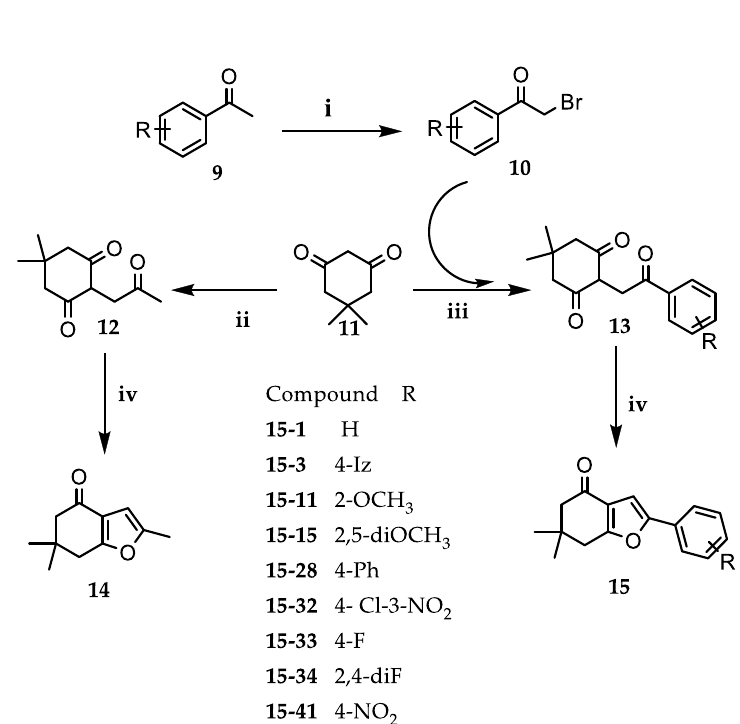
Scheme 3. Reaction conditions for the synthesis of benzofuran-4-ones.